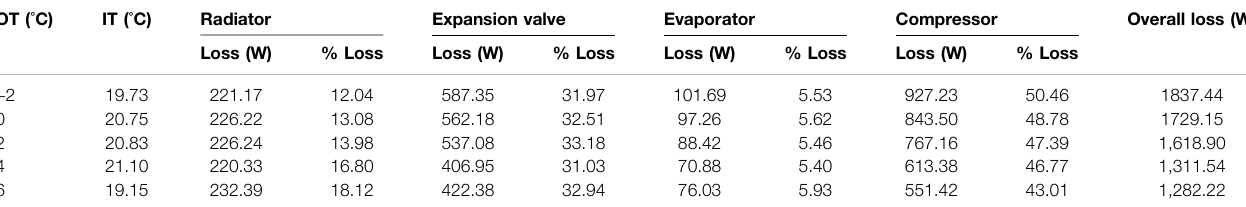
TABLE 4 | Exergy losses from different system